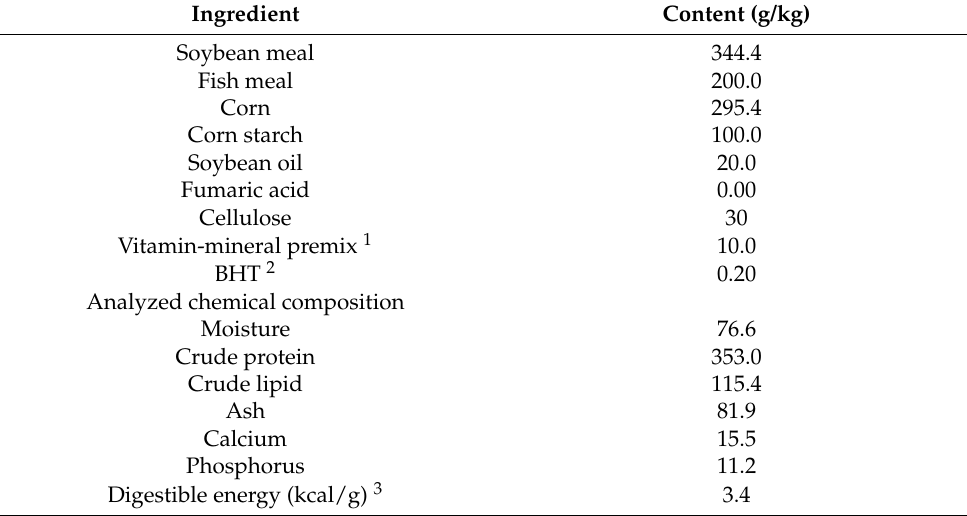
Table 1. Formulation and chemical composition (wet basis) of basal diet. Ingredient